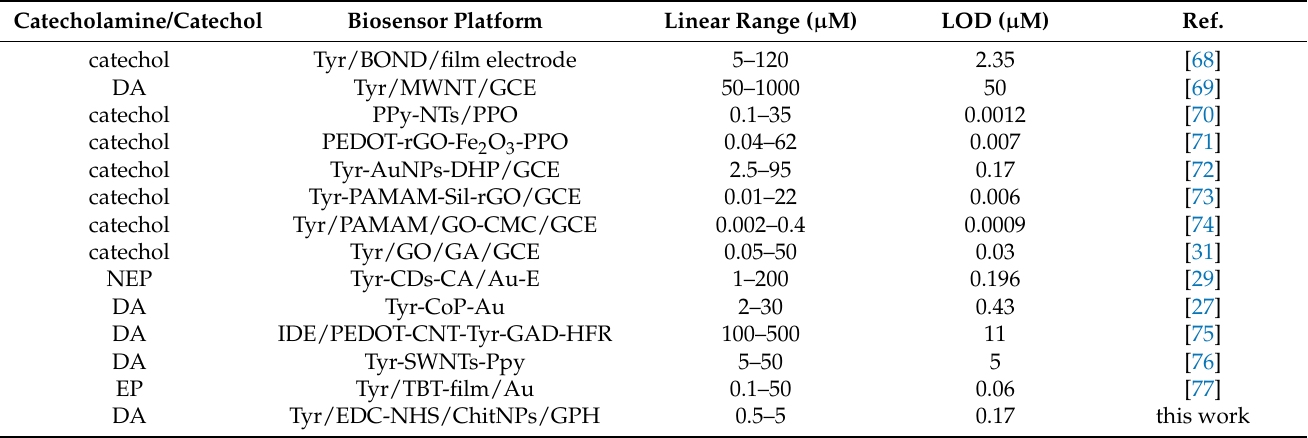
Table 3. Comparison of Tyr-based biosensors reported in the literature.